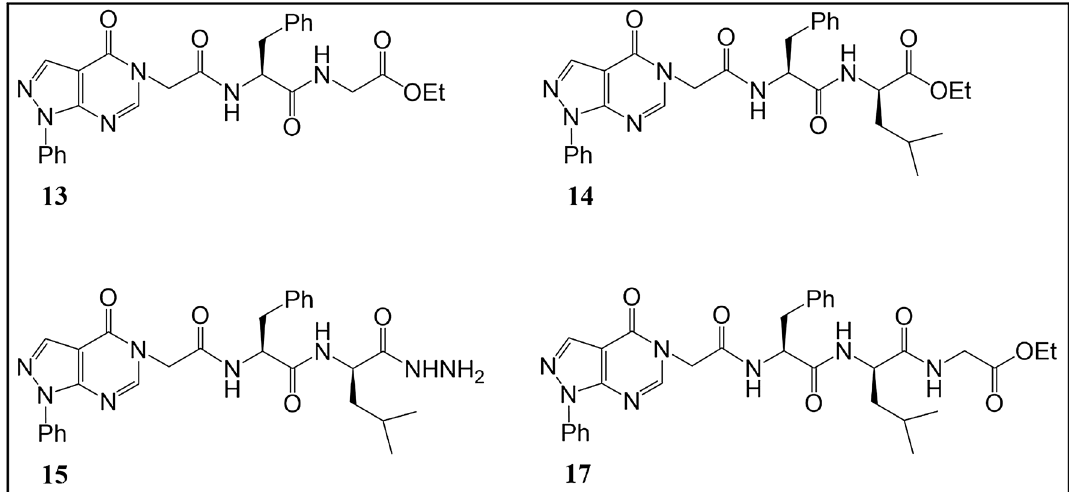
Fig. 1 Chemical structures for compounds 13 , 14 , 15, and